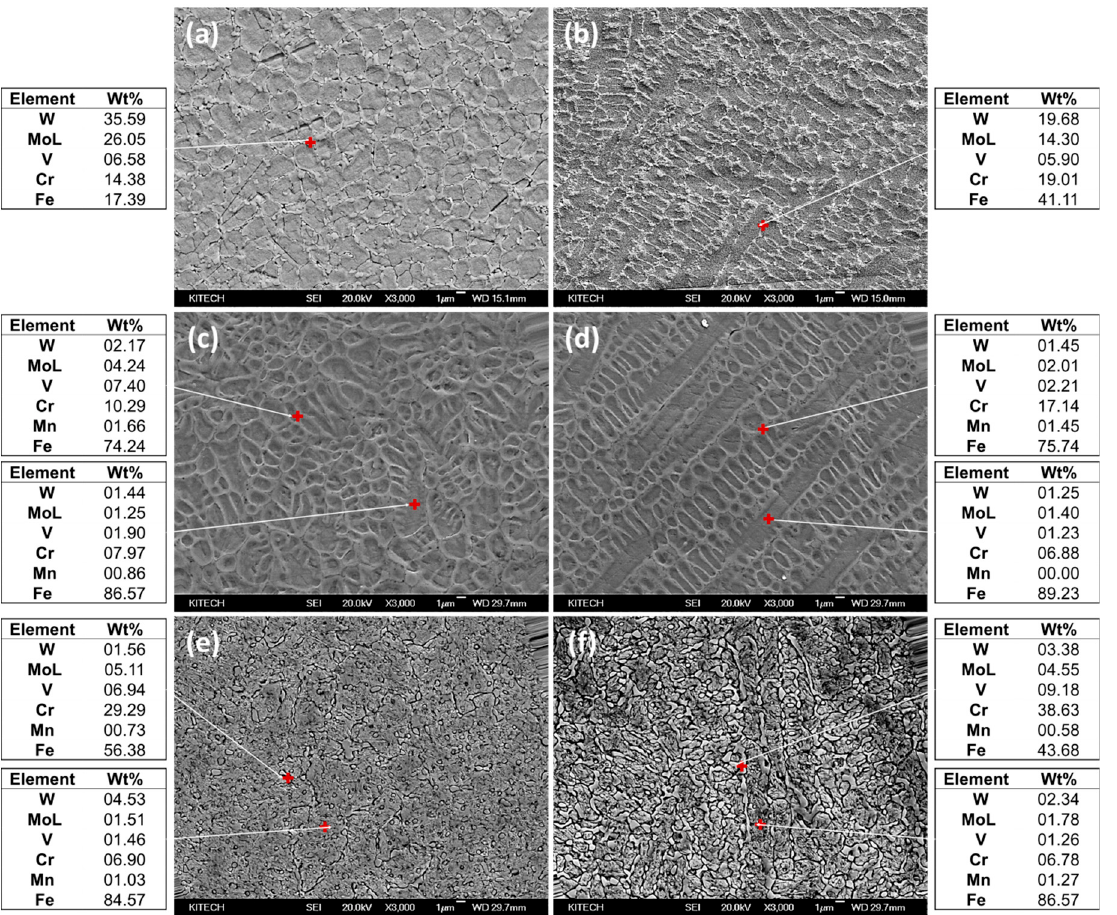
Figure 6. SEM image and elemental composition of deposition: ( a ) Deposited M4 region, ( b ) interface between M4 deposits and substrate, ( c ) deposited HWS region, ( d ) interface between HWS deposits and substrate, ( e ) post-deposition heat treated HWS (HT-HWS) region, and ( f ) interface region.